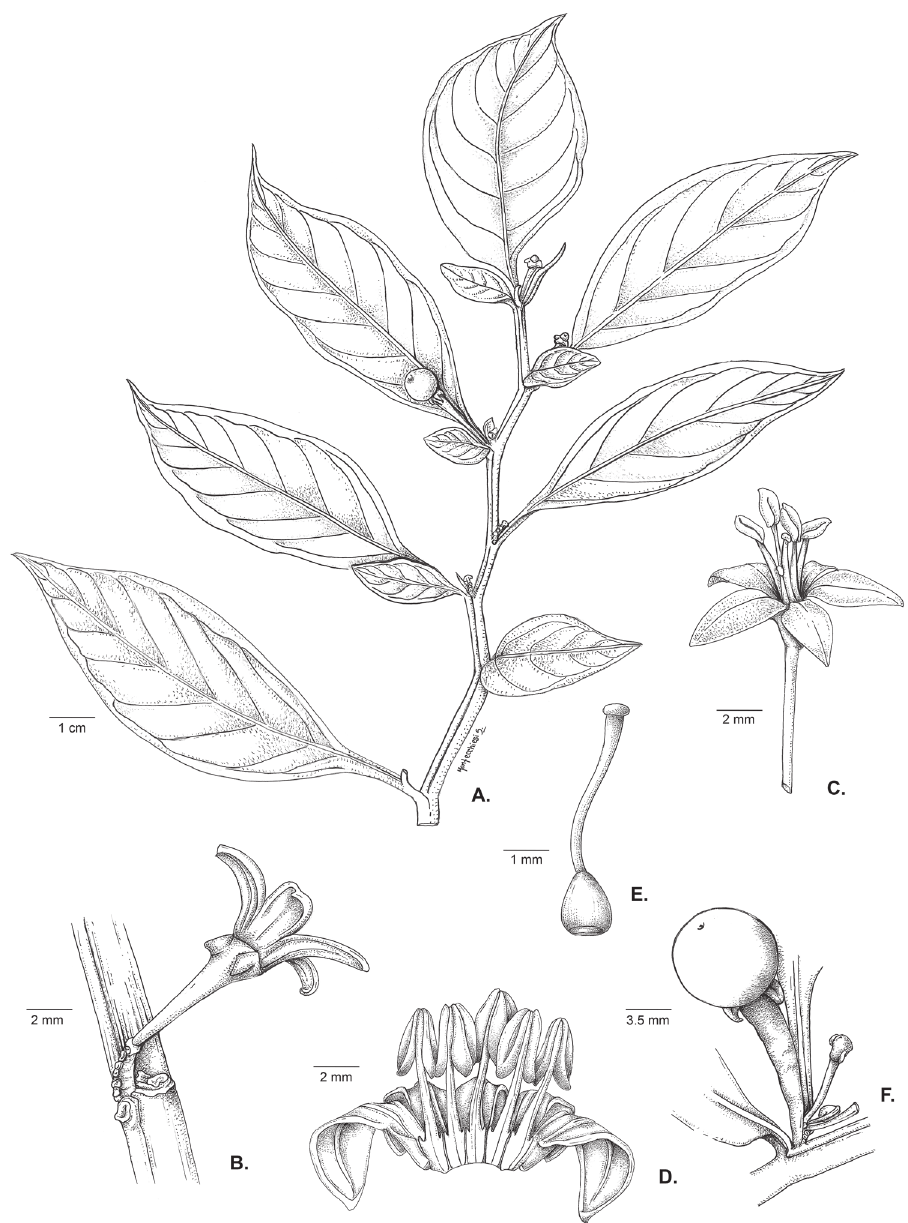
Figure 1. Capsicum regale Barboza & Bohs. A fruiting apical branch B unbranched inflorescence C flower, in lateral view D opened corolla E gynoecium F fruit. From Orejuela et al. 3034 . Drawn by S.